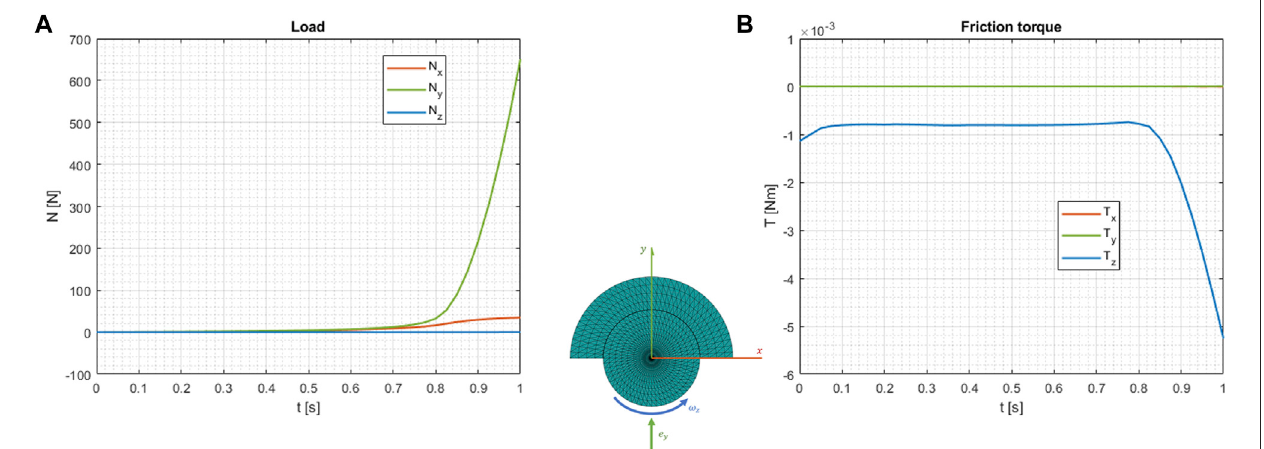
FIGURE 10 | Load (A) and friction torque (B) time evolution.